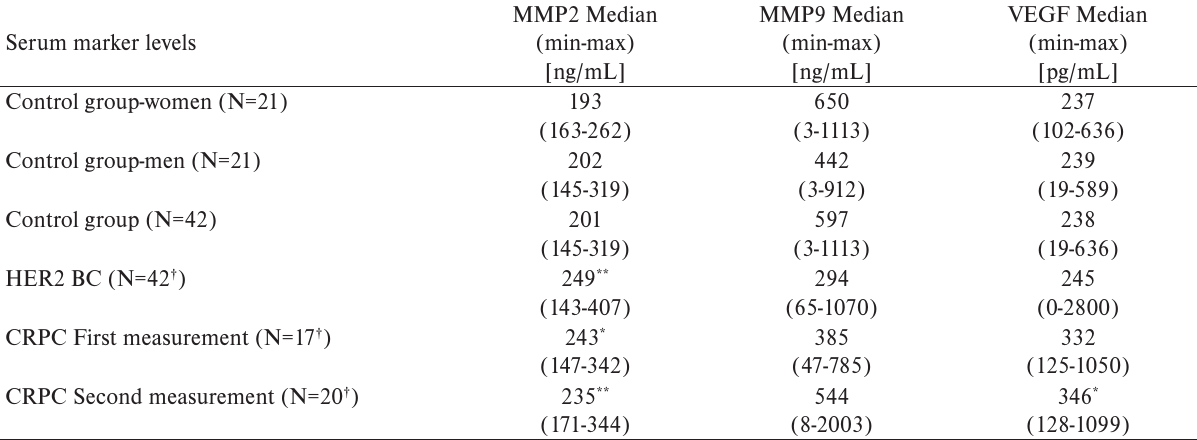
Table 2. Serum marker levels in the HER2 BC patiens, CRPC patients and control group.